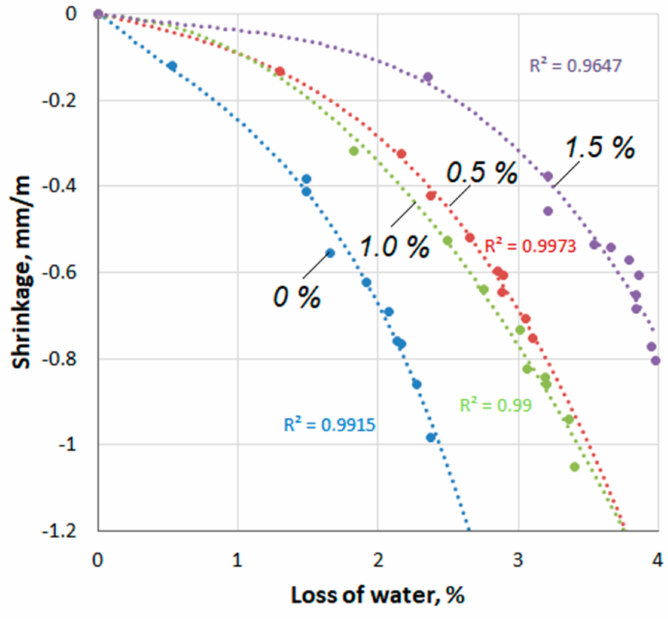
Figure 13. Dependence of shrinkage deformation on the amount of evaporated